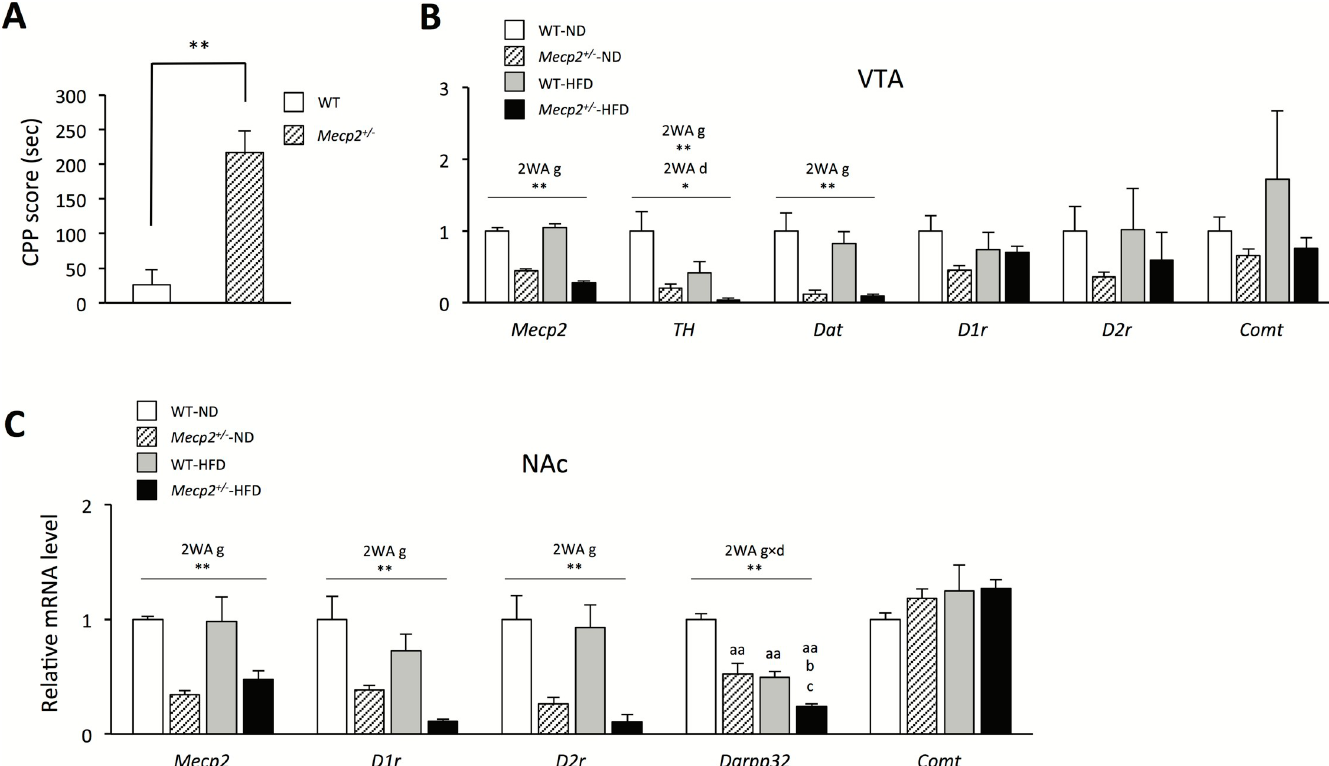
Fig 5. Dysregulation of the mesolimbic dopamine circuitry in Mecp2 +/- mice. (A) Conditioned place preference (CPP) test; mice were tested at 10–12 weeks of age. Values are the mean ± SEM for 8 mice. �� p < 0.01 vs. WT mice. (B) Mecp2 and dopamine-related gene expression in the VTA, determined using qPCR. (C) Dopamine- related gene expression in the NAc, determined using qPCR. (B–C) Mice were tested at 16 weeks of age; values are the mean ± SEM for five mice. � = p < 0.05, a p < 0.05, �� = p < 0.01, aa p < 0.01 vs. WT mice fed a normal chow diet (WT-ND). b p < 0.05, vs. Mecp2 +/- mice fed a normal chow diet ( Mecp2 +/- -ND). c p < 0.05, vs. WT mice fed a high-fat diet (WT-HFD). 2WA = Two-way ANOVA, g = genotype, d = diet, Two-way ANOVA followed by post-hoc Tukey-Kramer Multiple- Comparison test.